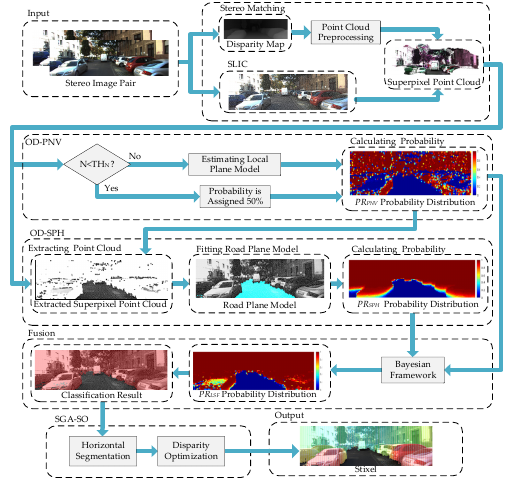
Figure 1. Flow chart of OD-LSF.